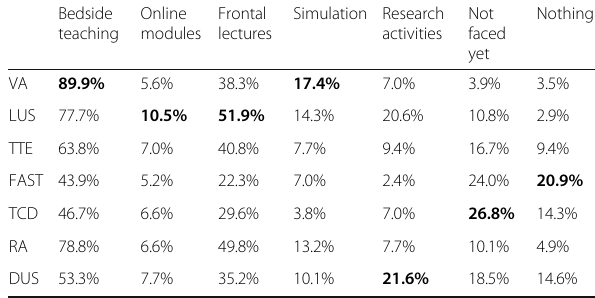
Table 1 (abstract 001641). Teaching instruments adopted for different ultrasound techniques (VA: vascular access; LUS: lung ultrasound; TTE: transthoracic echocardiography; FAST: focused-assessment sonography trauma; TCD: transcranial Doppler; RA: regional anesthesia;